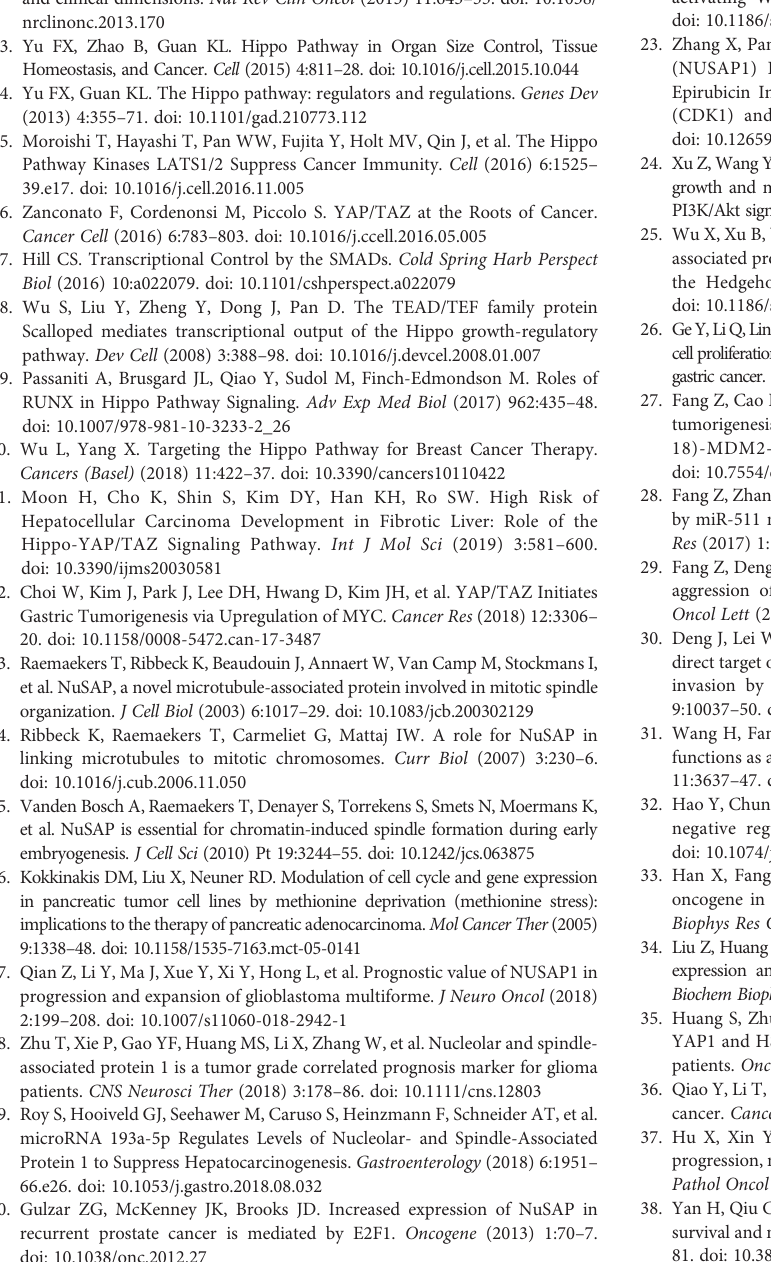
stained modi fi ed SGC7901 and MGC803 cells in the Transwell invasion assays (magni fi cation, ×200). (G, H) Cell migration ability evaluated by wound-healing assays (magni fi cation, ×100). Student ’ s t test: * p <0.05, ** p